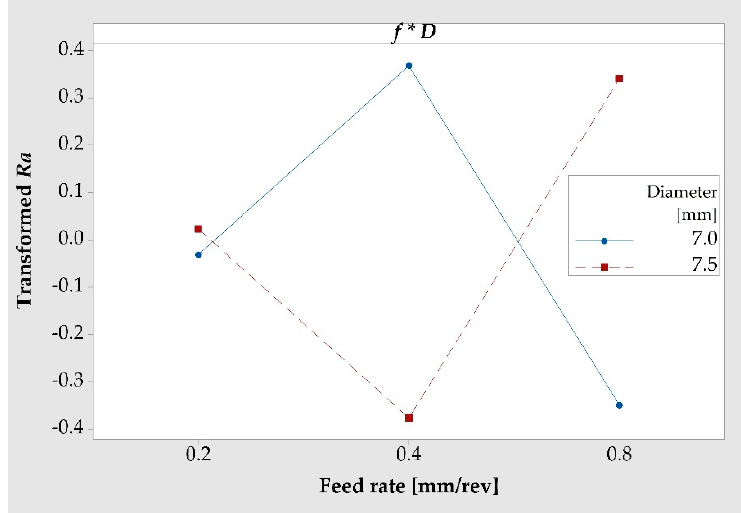
Figure 9. Interaction graph between feed rate and diameter, f*D .